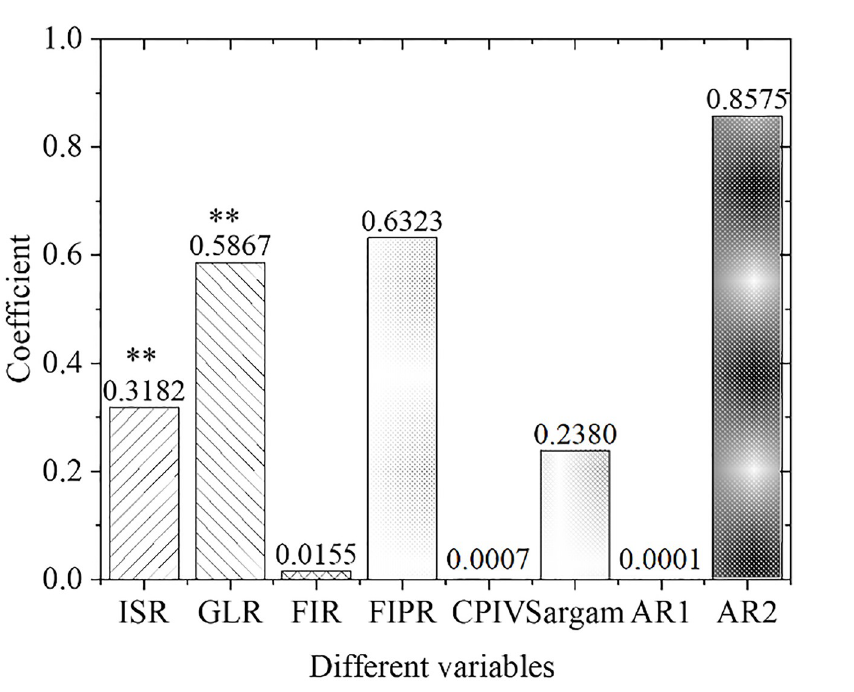
Fig 11. Estimation results of empirical panel coefficient in Western China.